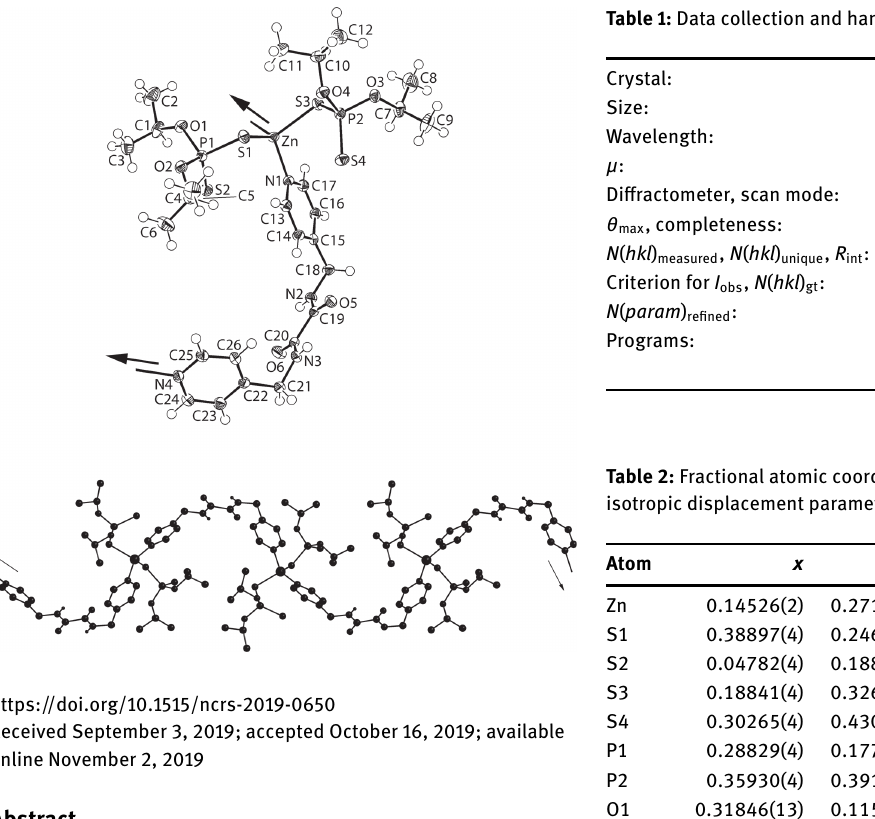
Table 1 contains crystallographic data and Table 2 contains the list of the atoms including atomic coordinates and dis- placement parameters.